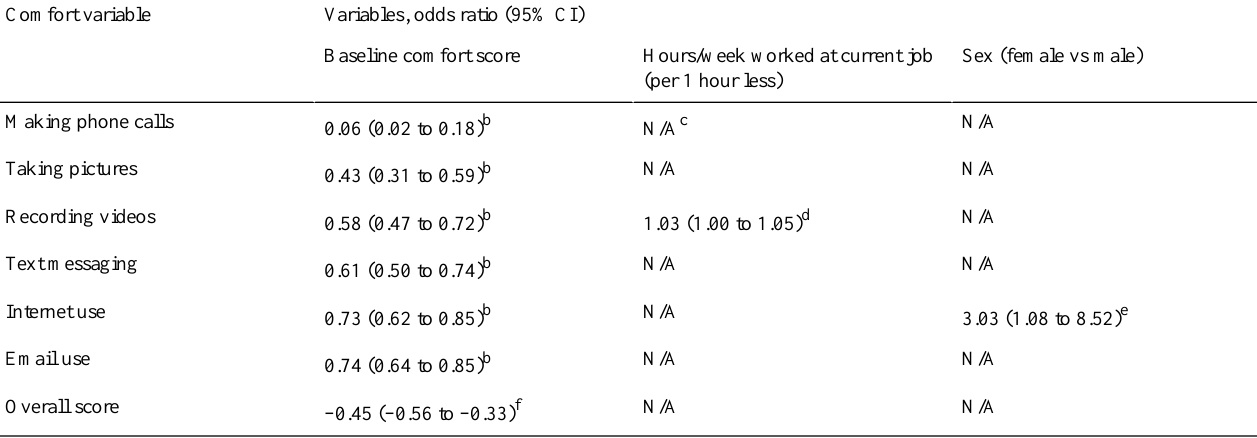
Table 3. Multivariable regression model a for associations with change in comfort using mobile phone functions among VDOT